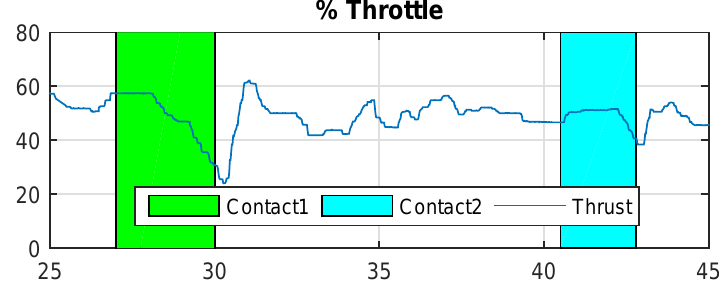
Figure 20. % Throttle—Grazalema bridge experiments.